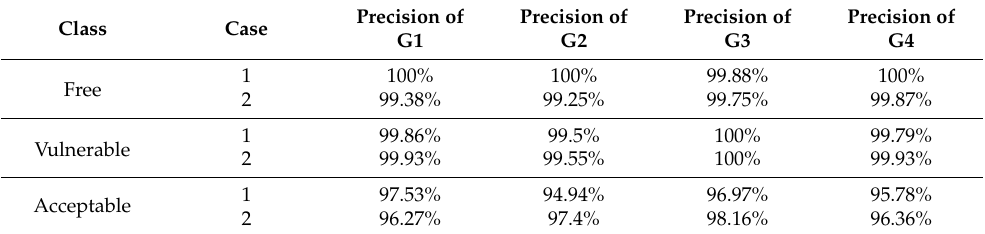
Table 5. Prediction precision of DCNN–SVM for collision classification.